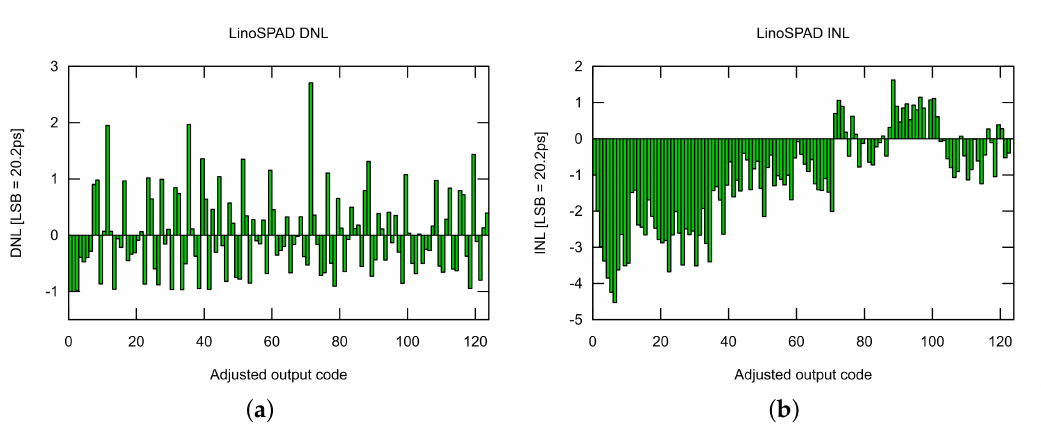
Figure 9. Uncorrected: differential non-linearity (DNL) ( a ); and integral non-linearity (INL) ( b ) characteristics of an FPGA TDC. Completely unused bins have been removed from the plots, resulting in a least-significant bit (LSB) of 20.2 ps. The first codes are rarely used, leading to an unusual negative excursion in the